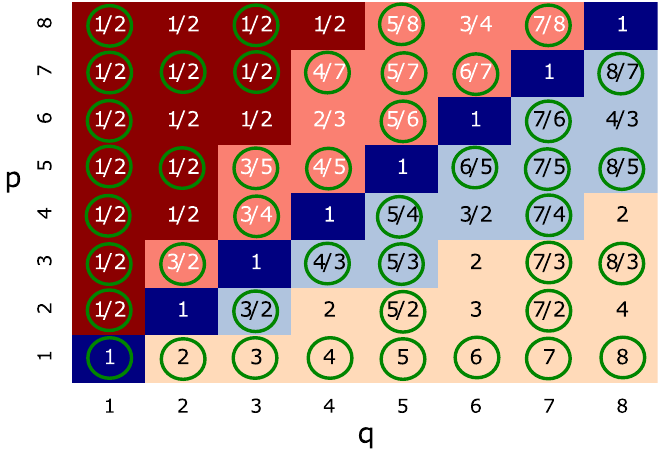
ν y and ν z is always =